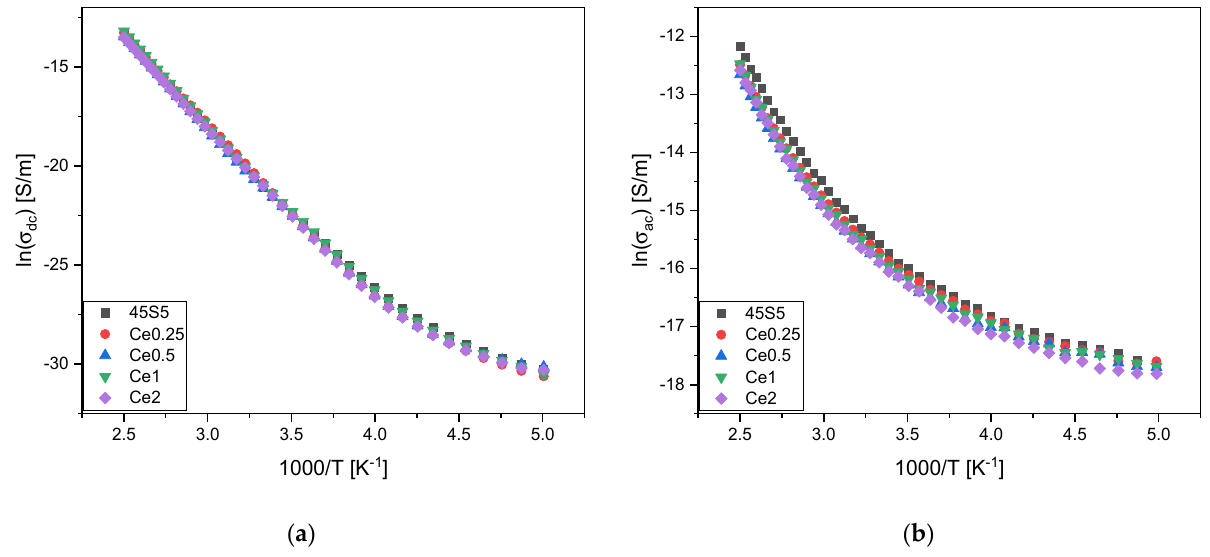
Figure 5. Sum of areas of Q 0 and Q 1 +Q 2 +Q 3 (NBOs) units of the 45S5, Ce0.25, Ce0.5, Ce1 and Ce2 samples.